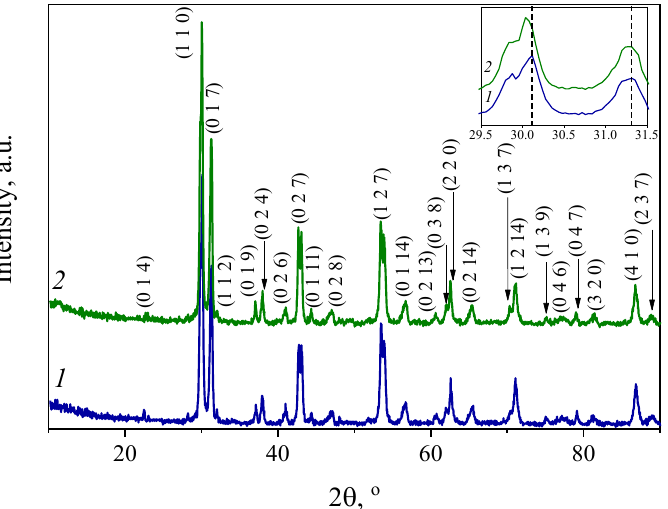
Figure 1. X-ray powder diffraction patterns for Ba 5 In 2 Al 2 ZrO 13 ( 1 ) and Ba 5 In 2.1 Al 2 Zr 0.9 O 12.95 ( 2 ); the